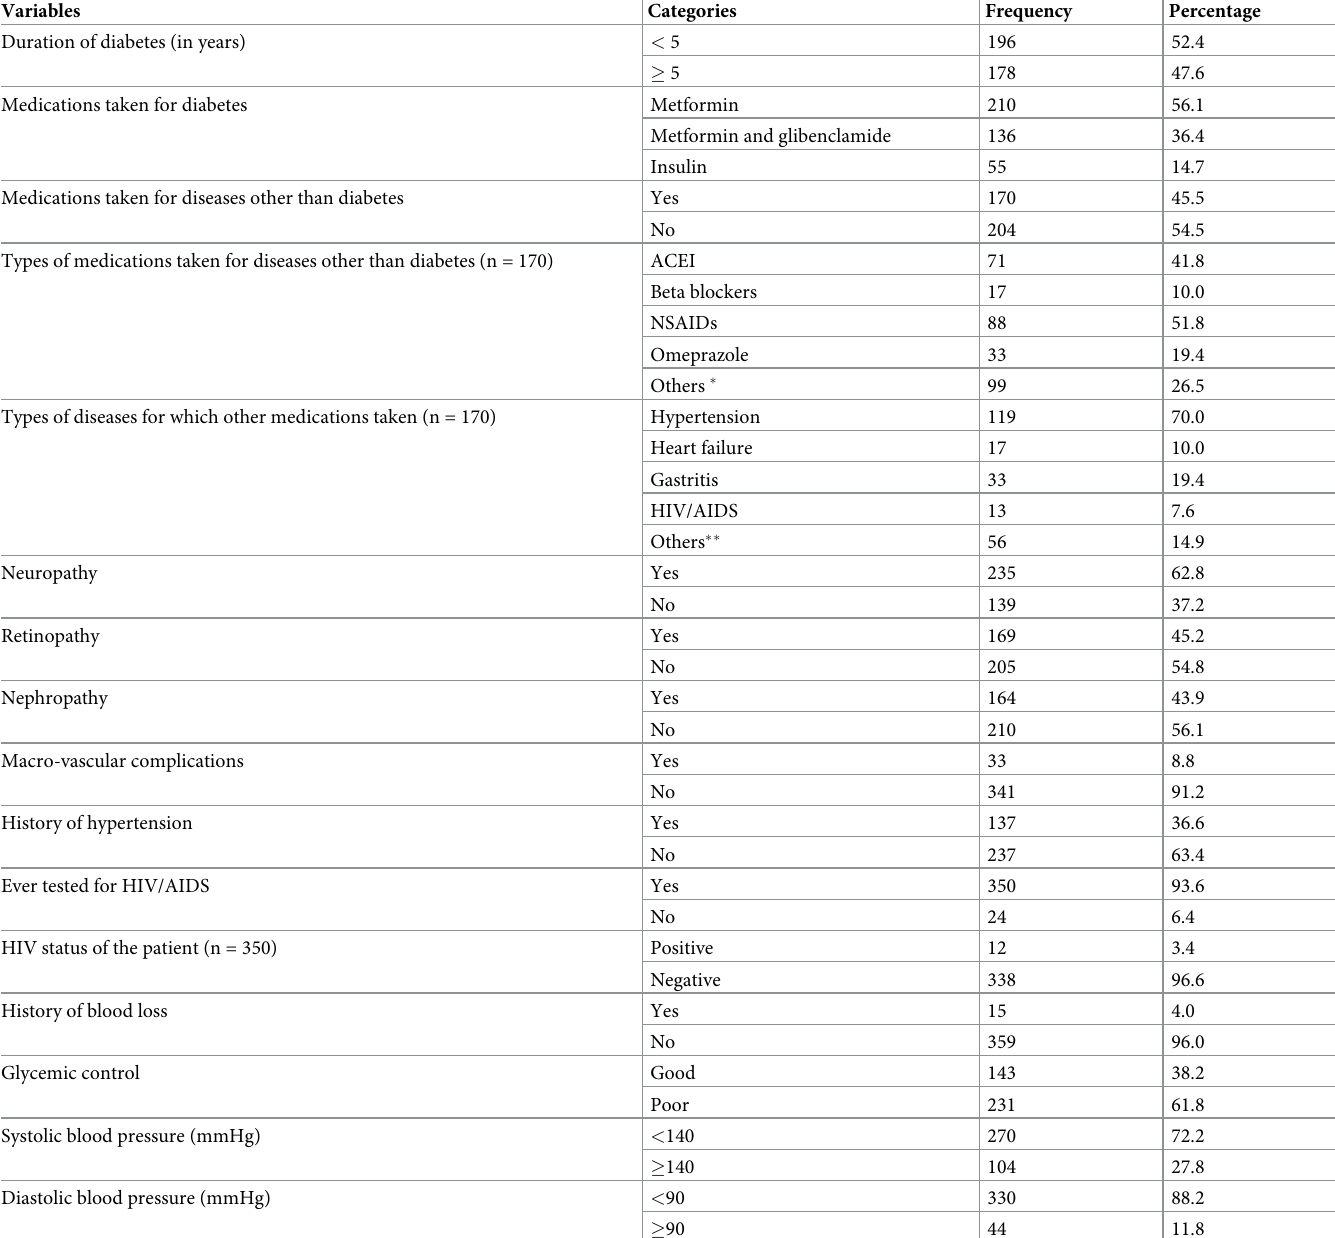
Table 3. Clinical conditions ofT2DM patients attending public hospitals in Harari region, Eastern Ethiopia, February to March2019 (n = 374).